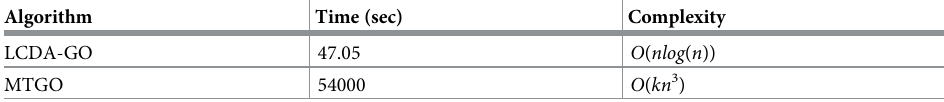
Table 6. Complexity and run time of algorithms incorporating GO on Krogan